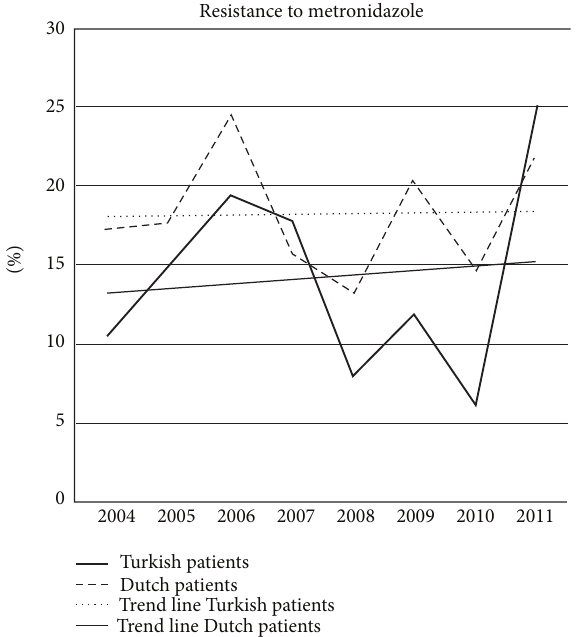
Figure 4: Resistance to metronidazole in Dutch patients and Turkish patients in the consecutive eight